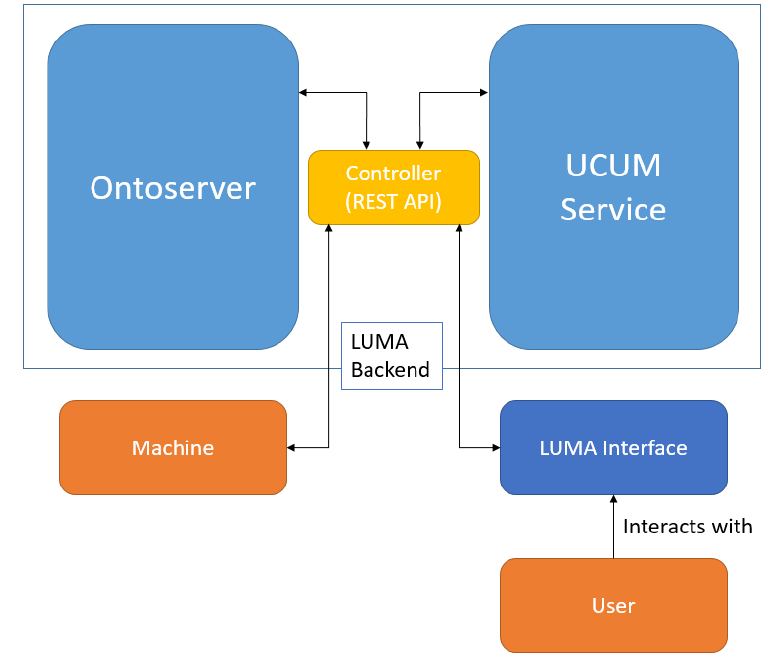
Figure 5. This figure shows the interactions of each component. The Controller manages the flow of information and triggers the terminology server Ontoserver and the UCUM service in order to generate responses related to mapping tasks. Machines interact with the Controller via its REST interface, while humans do so via the graphical user interface LUMA. The communication happens via HTTP calls and the JSON file format is used for data